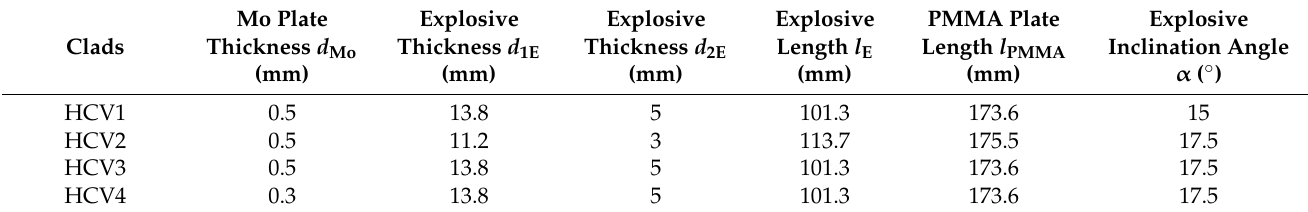
Figure 1. Schematic illustrations of explosive welding settings used for ( a ) low horizontal collision velocity (LCV), ( b ), high horizontal collision velocity (HCV)1–4 clads. ( a , b ) S.O.D: stand-off distance, ( b ) PMMA: polymethyl methacrylate, and setup parameters for HCV1–4 clades are shown in Table 2. Table 2. Under-water explosion welding setup parameters for HCV1–4 clads.